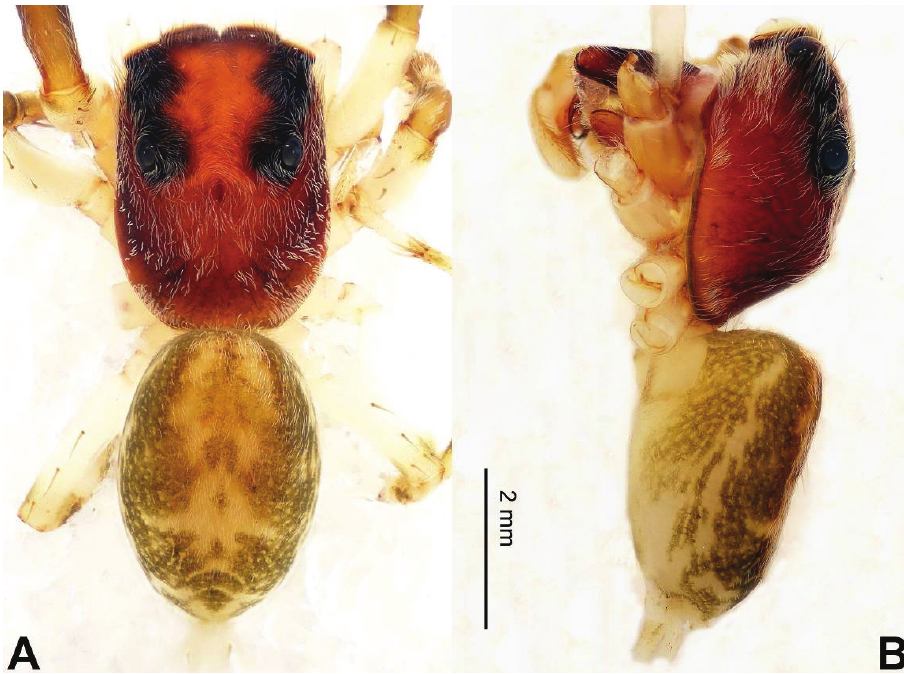
Figure 22. Habitus of Cytaea yunnanensis sp. n., male holotype. A dorsal B lateral.